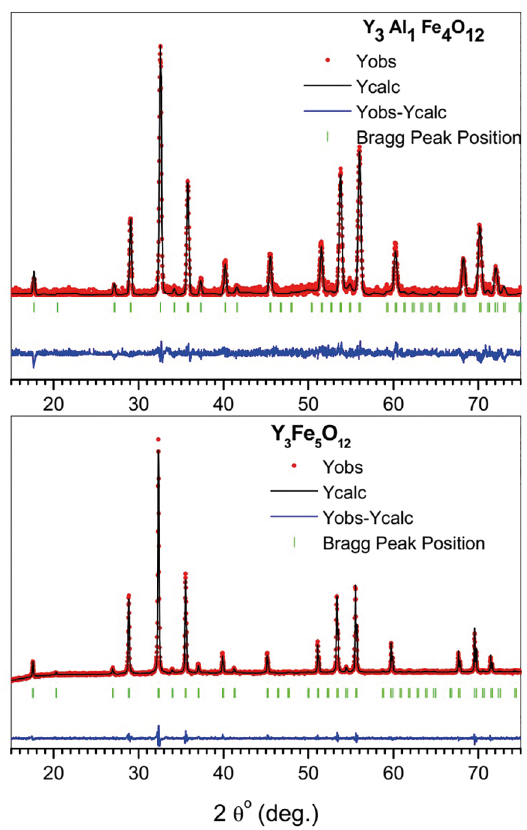
Al Fe O garnet samples 3 x (5- x ) 12 - Y ) between obs calc ) is given in the calc